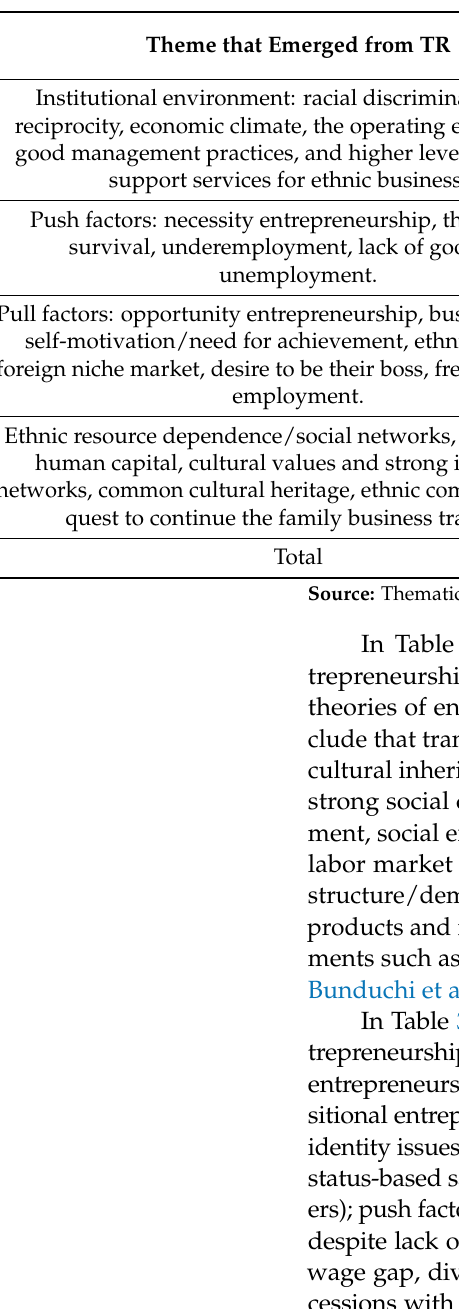
Table 1. Motivational factors for ethnic